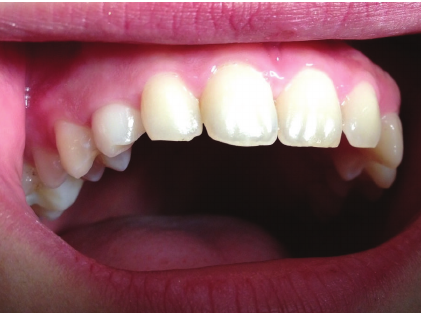
Figure 3: Periapical radiograph of the left mandibular molar region, showing the osteosclerotic